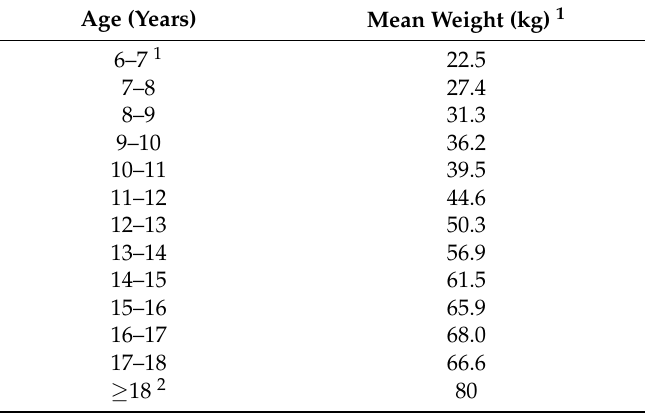
Table 2. Mean Weights by Age Used in Lowest Therapeutic Dose